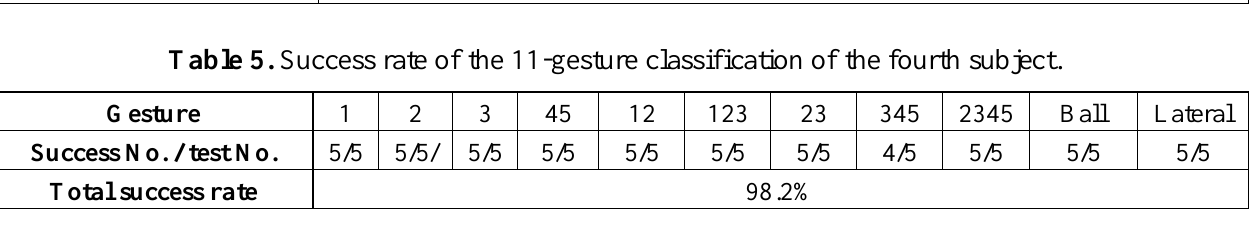
Table 6. Success rate of the 11-gesture classification of the fifth subject.